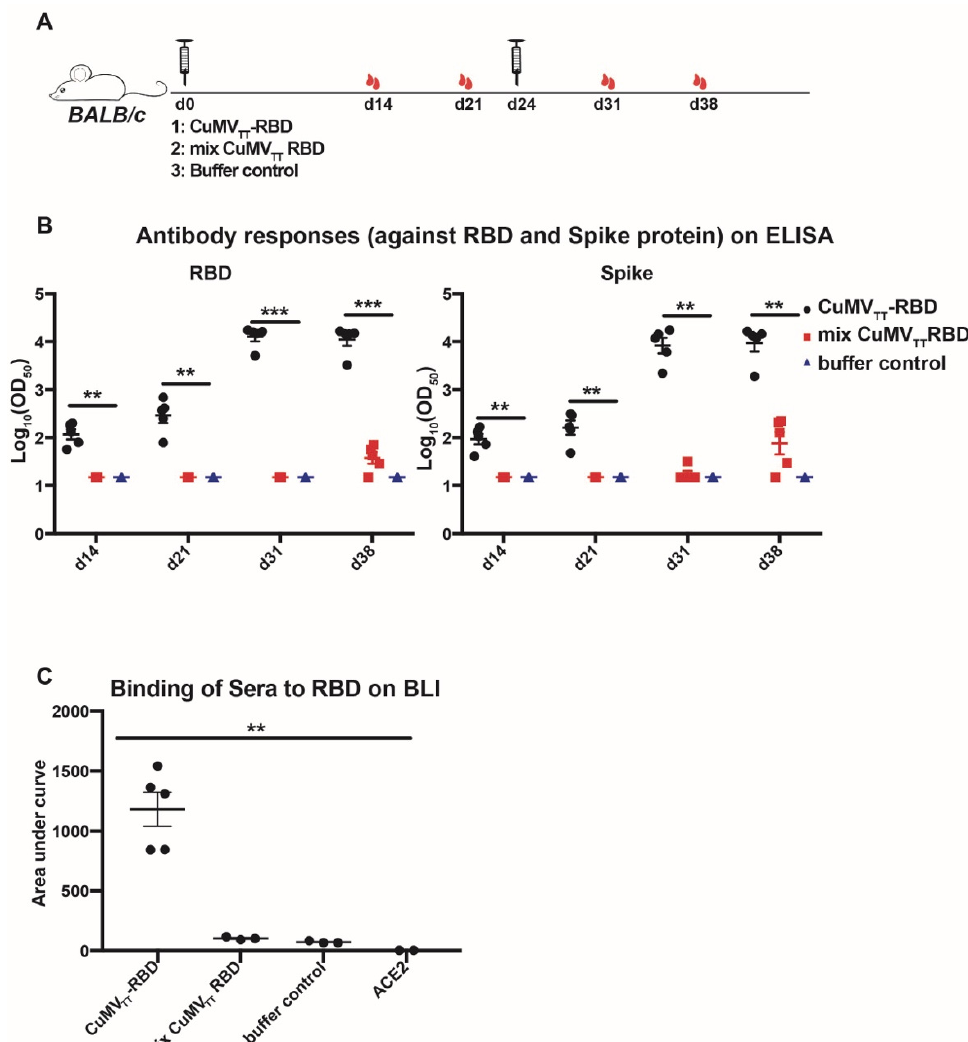
Figure 2. The CuMV TT –RBD vaccine induces high RBD-specific antibody titers. ( A ) Vaccination regimen: mice (5 per group) were vaccinated by subcutaneous injection with either 40 μ g CuMV TT –RBD or mixed 40 μ g CuMV TT and 40 μ g RBD or with Tris buffer (20 mM Tris-HCl, 5 mM EDTA, pH 8.0) at d0 and d24. Serum samples were harvested on days 14, 21 31, and 38 after first vaccination. ( B ) Serum samples were tested for binding to the RBD and spike protein by ELISA. An amount of 1 μ g/mL of the RBD or spike protein was coated on the plates, and mouse sera were added in threefold serial dilutions starting at 1:20. The results are expressed as OD 50 (the dilution that reached half OD max ). Shown are a scatter plot of the IgG titers of individual mice ( n = 5 mice). ( C ) The binding of sera to the RBD was assessed by biolayer interferometry (BLI) (octet). The sera of immunized mice at d31 after first immunization (1:20 dilution) were incubated with the RBD immobilized on a biosensor, and area under the curve (responses with time) was assessed. Shown are a scatter plot of the binding responses of individual mice ( n > 3 mice). Statistical analysis was performed with unpaired t -test and p ≤ 0.01 (**), p ≤ 0.005 (***).